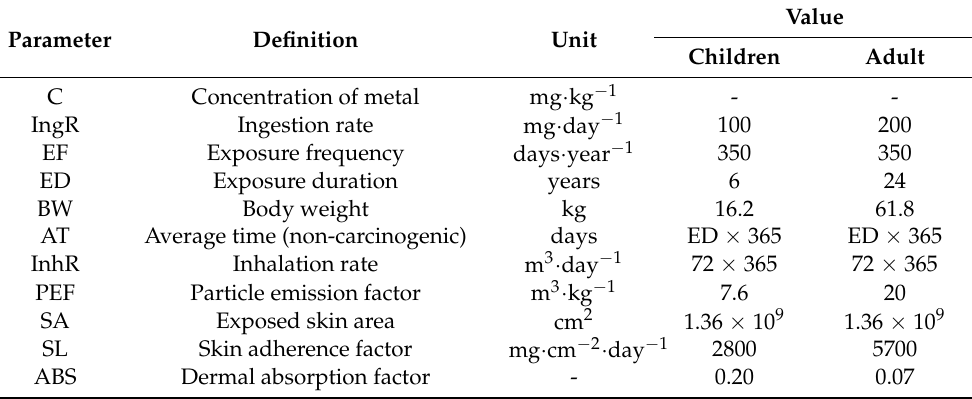
Table 3. Exposure factor values used in average daily intake (ADI) estimation for non-carcinogenic risk for children and